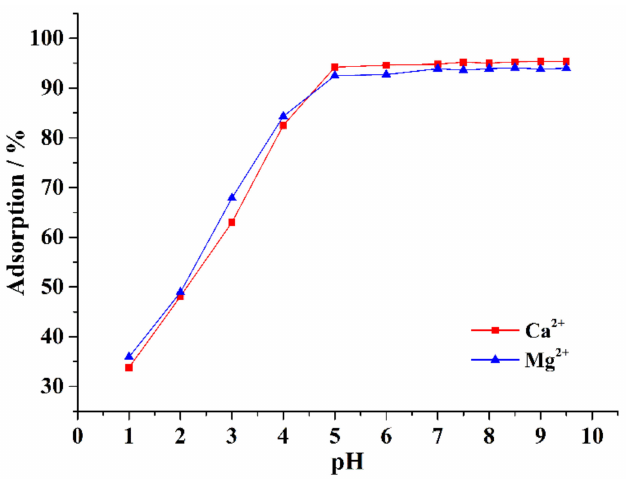
Figure 4. Influence of the acidity of the solution on the adsorption performance of CA–SC for Ca 2+ and Mg 2+